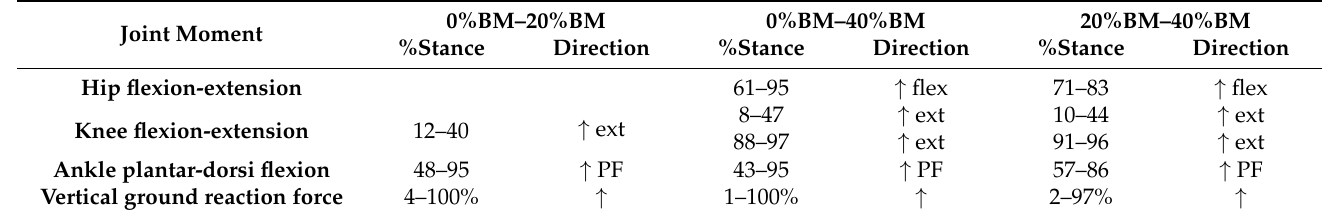
Table A2. Overview of the direction and timing of kinetic changes between loading